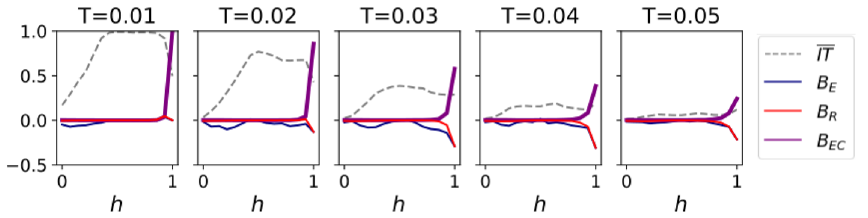
Figure 8. Bias variables IT , B E , B R and B EC as a function of the homophily parameter h , for Complex Contagion dynamics. The simulation parameters are the same as in Fig. 3b.